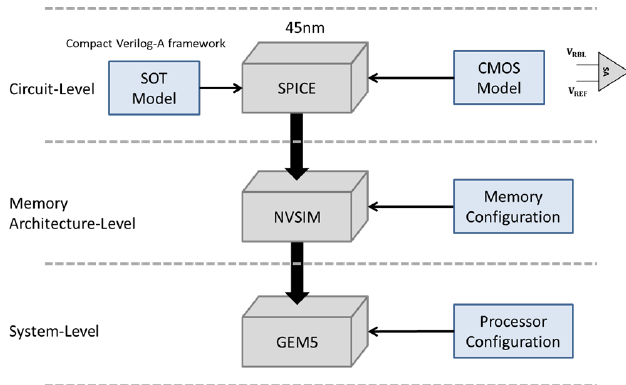
Figure 10. Experimental